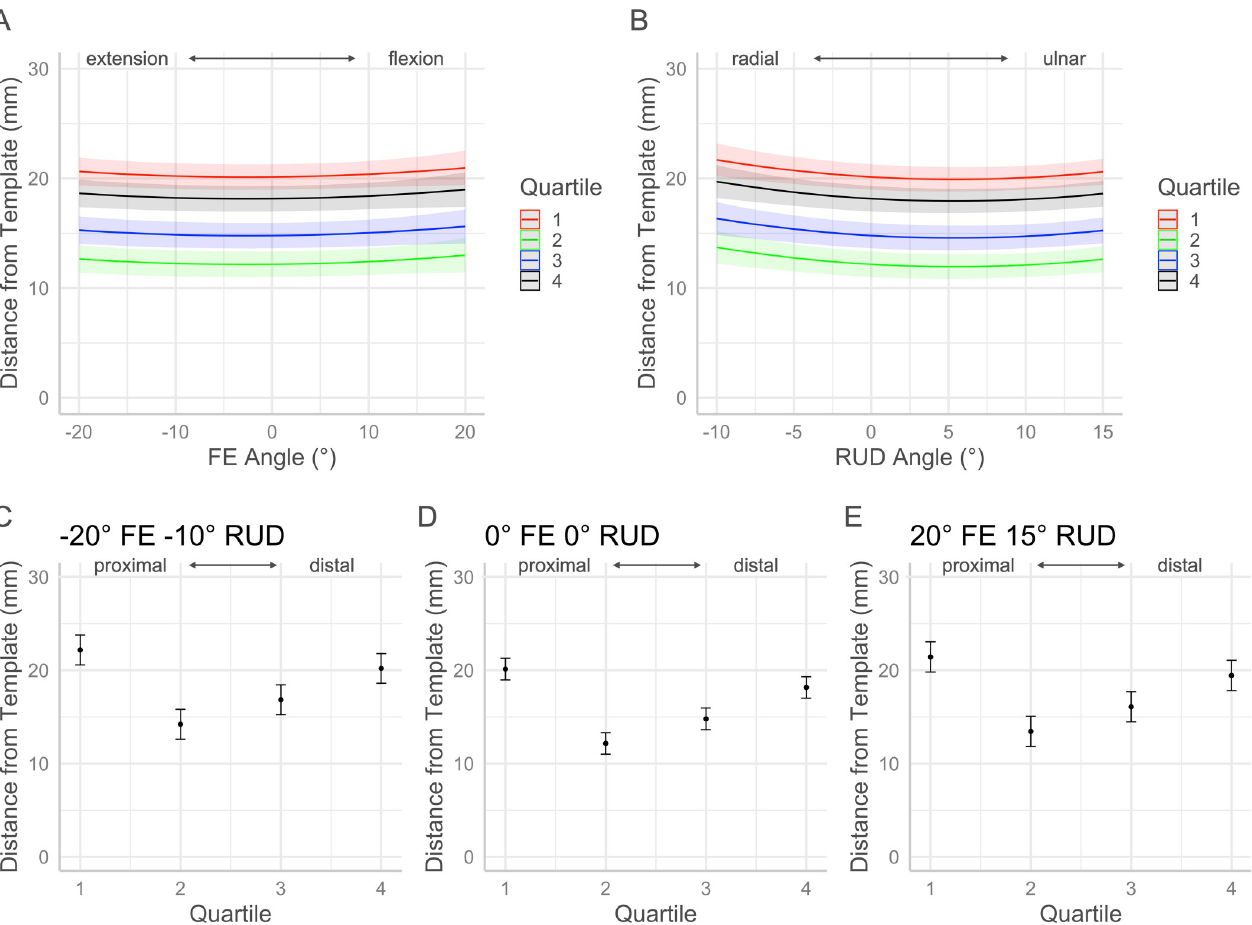
Fig 9. Effects of FE and RUD wrist postures on the mean shape signature distance from the template within each quartile. Panel A shows the effects of varying FE angle with 0˚ RUD. Panel B shows the effect of varying RUD angle with 0˚ FE. Panels C/D/E show the predicted values with 95% confidence intervals for each quartile for an extended radially deviated posture (panel C), a neutral posture (panel D), and a flexed and ulnarly deviated posture (panel E).